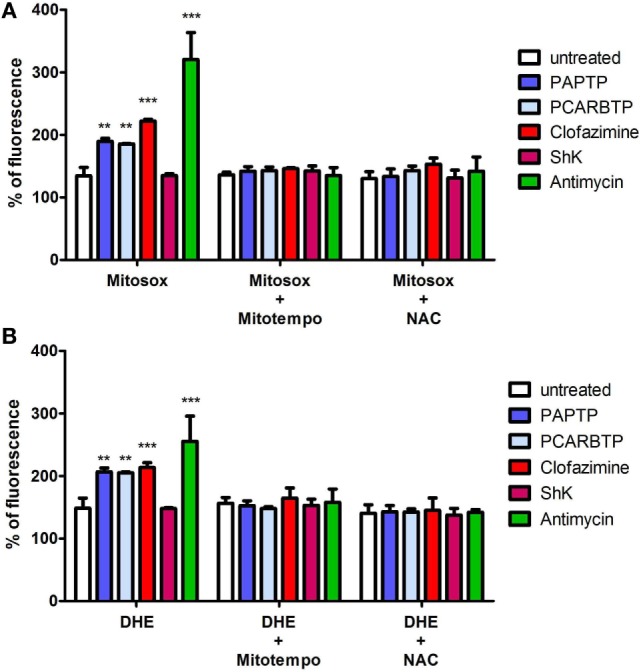
Low concentrations of PAP-1 derivatives induces ROS production. (A) Quantification of mitochondrial ROS production in PANC-1 cells after 2 h of incubation with PAPTP, PCARBTP, and ShK (all 100 nM), Antimycin A (2 µM) or clofazimine (1 µM) by Mitosox (1 µM). Where indicated cells were pre-treated with ROS scavengers Mitotempo (50 µM) or N-acetylcysteine (NAC) (20 mM) for 1 h. Values are reported as percentage of Mitosox fluorescence compare to 0 h ± SEM (n = 3; **p > 0.01; ***p < 0.001). (B) Quantification of intracellular ROS production in PANC-1 cells treated as in (A) after 2 h by DHE (1 µM). Values are reported as percentage of DHE fluorescence compare to 0 h ± SEM (n = 3; **p > 0.01; ***p < 0.001).